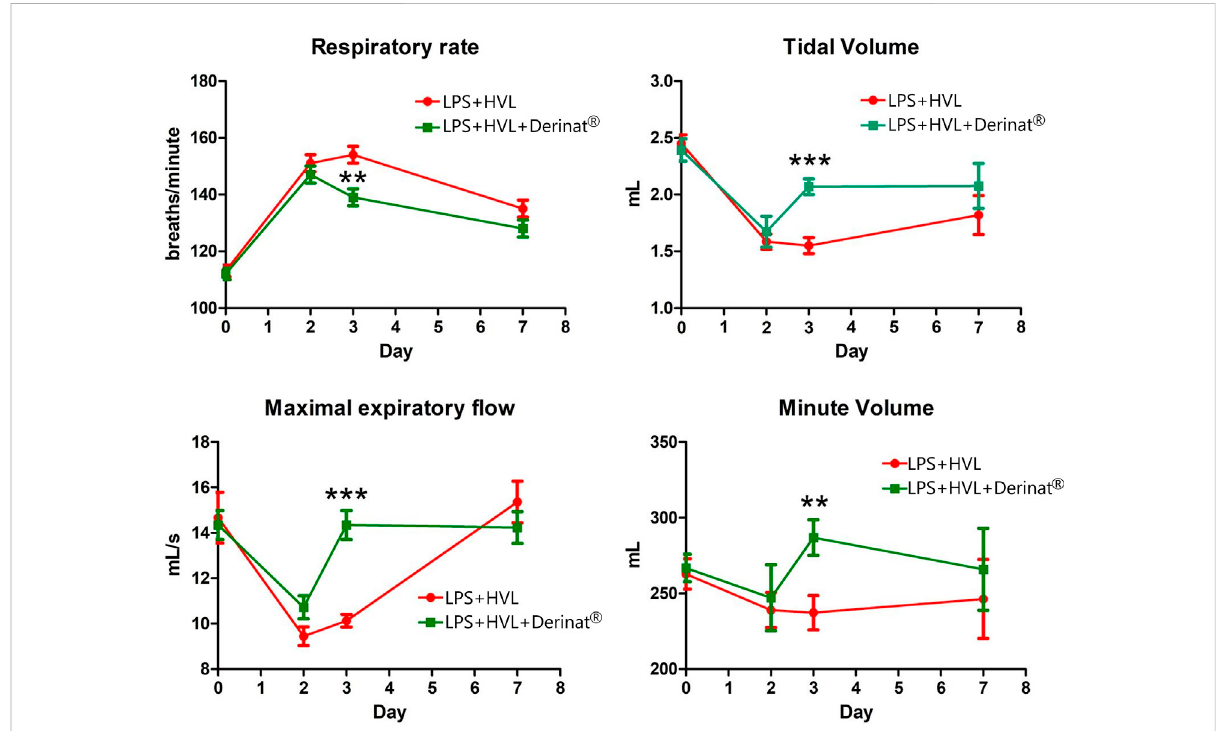
FIGURE 2 Dynamics of functional changes in the respiratory system of rats (minute volume of respiration; volume of respiration; respiratory rate; maximum expiratory fl ow) with the simulation of APL on thebackground of the introduction of saline or Derinat ® . * - p < 0.05, ** - p < 0.01, *** - p < 0.001 relative to the control group without ALI modeling according to the Mann-Whitney U test.